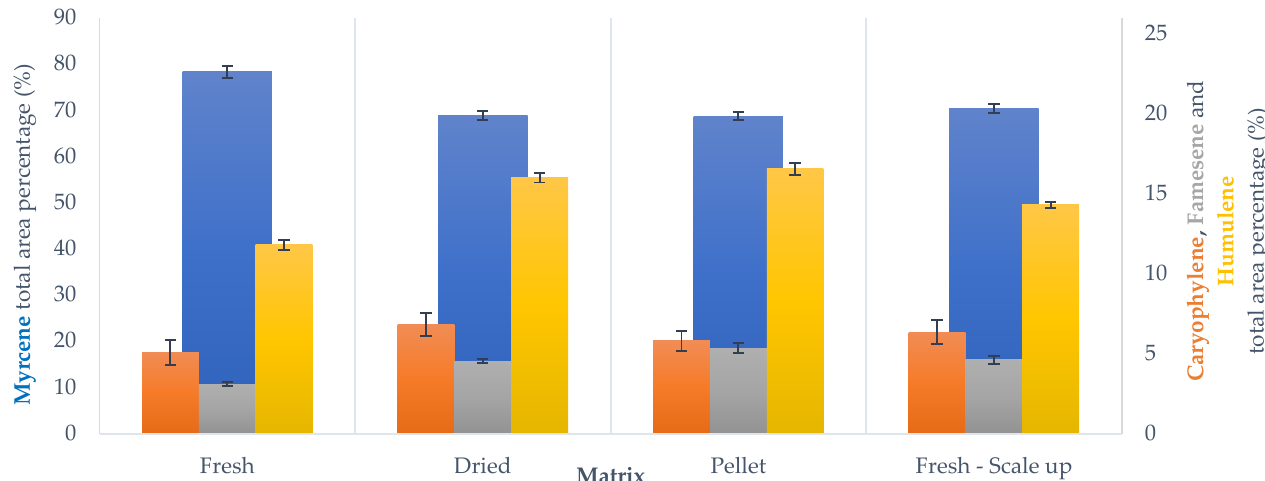
Figure 9. Main terpenoid distribution across mild irradiation MAHD and scale-up screenings, GC-MS analysis. Results reported as average ± SD.